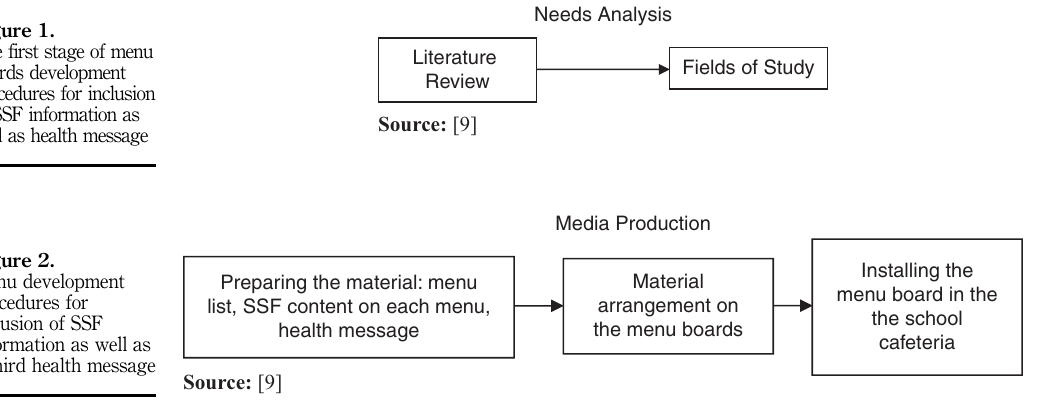
Figure 1. The first stage of menu boards development procedures for inclusion of SSF information as well as health message